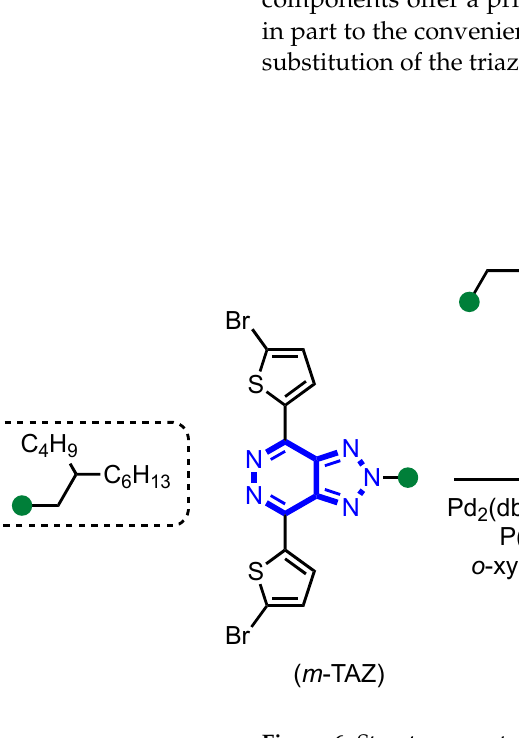
Figure 6. Structures containing the 1,2,3-triazolo[4,5- d ]pyridazine-based monomer, m -TAZ, used to construct highly conjugated TAZ-based polymers.